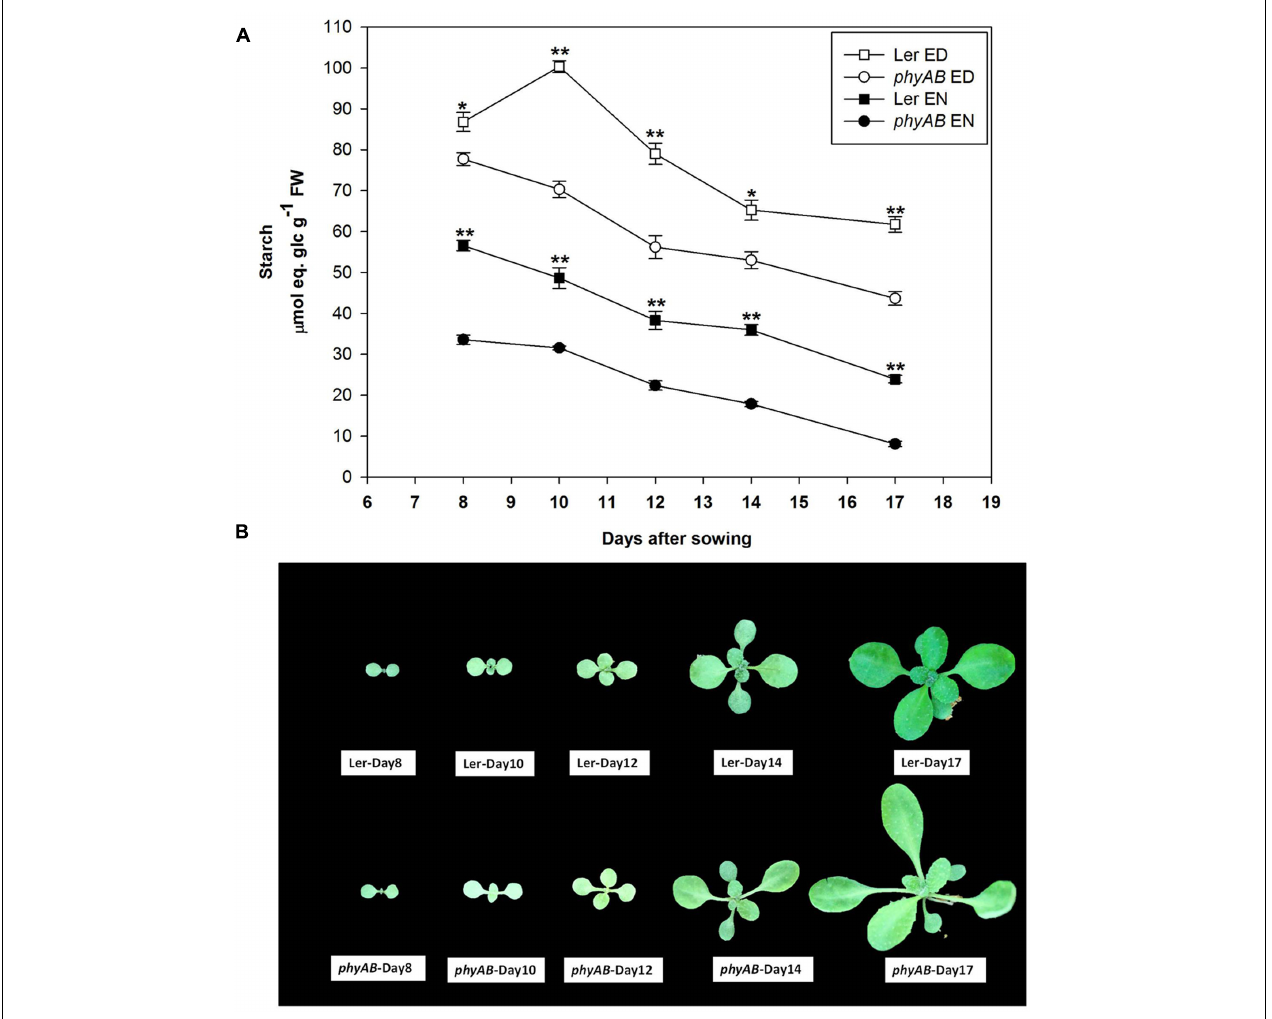
FIGURE 2 | Starch content and morphology of phyAB and WT during the vegetative growth. (A) Starch contents at ED and EN in phyAB and WT. Results are mean ± SE of measurements made on three biological replicates. Asterisks indicate statistically significant differences of starch contents at ED or at EN between phyAB and WT ( ∗ P < 0.05; ∗∗ P < 0.01). (B) Pictures of WT and the phyAB mutant before harvest. Plants were grown under FL1 with PPFD of 125 ± 5 µ mol m − 2 s − 1 .